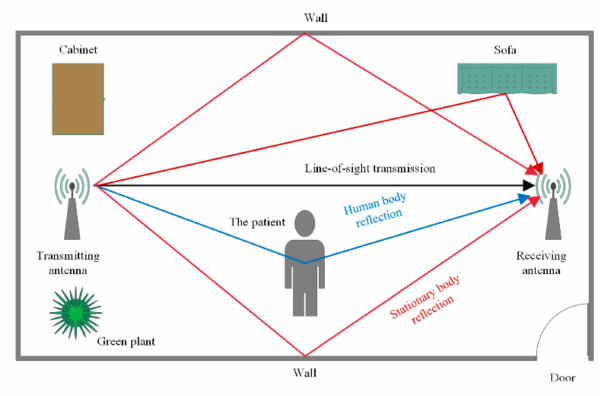
Figure 1. Indoor propagation model of wireless